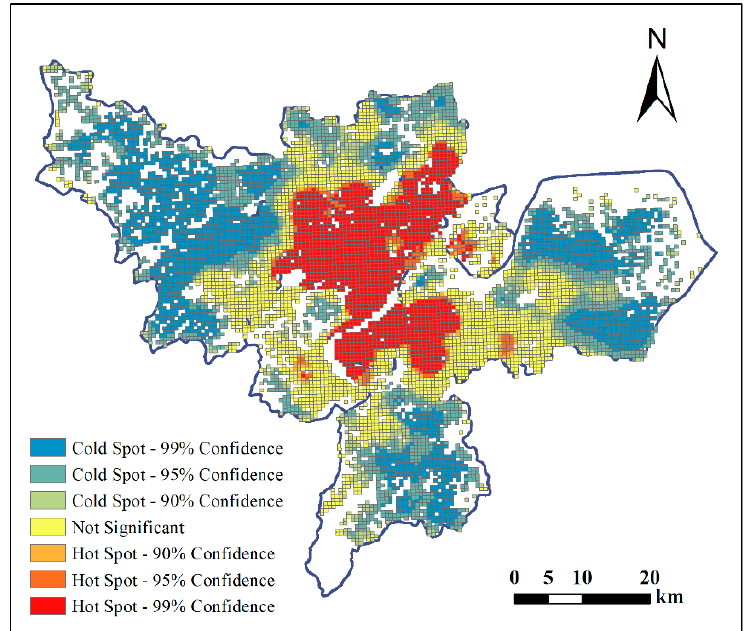
Figure 12. Hot spot analysis result of population data.